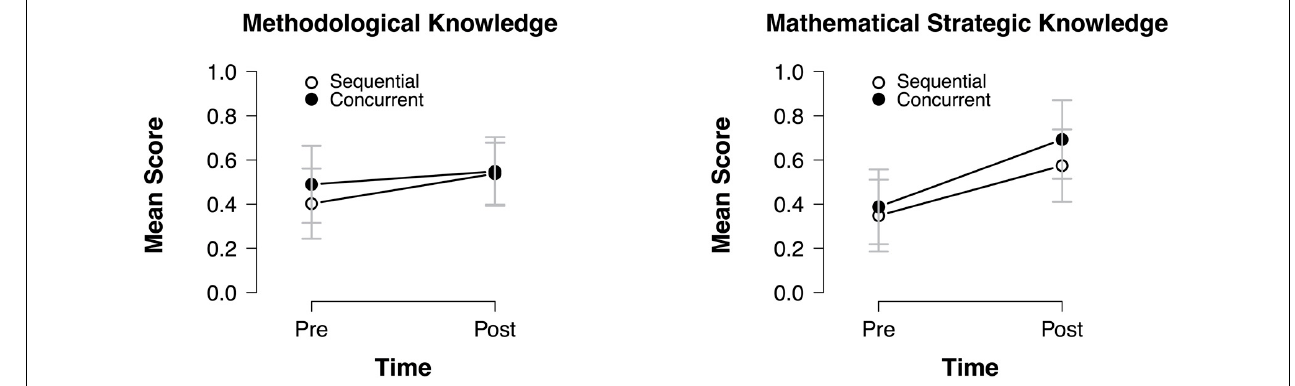
FIGURE 5 | Effects of both approaches on methodological knowledge (left) and mathematical strategic knowledge (right).